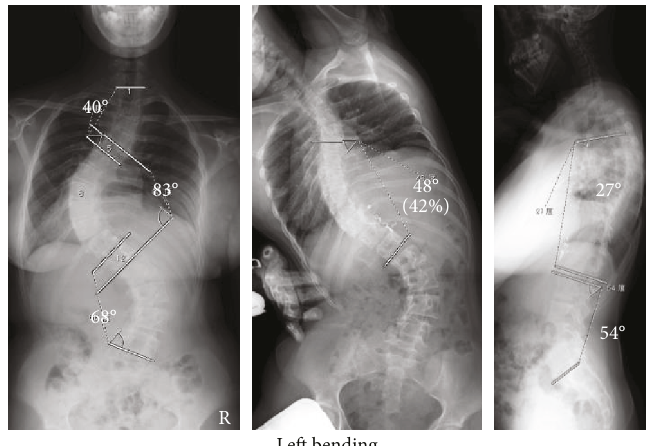
Figure 1: Case 1: preoperative radiographs (from left to right: anteroposterior, side-bending, lateral). Anteroposterior radiograph shows an 83 ° left convex main thoracic curve, a 40 ° proximal thoracic curve, and a 68 ° lumbar curve. Side-bending radiograph shows 42% fl exibility at the main thoracic curve. Lateral radiograph shows thoracic kyphosis of 27 ° and lumbar lordosis of 54 ° .